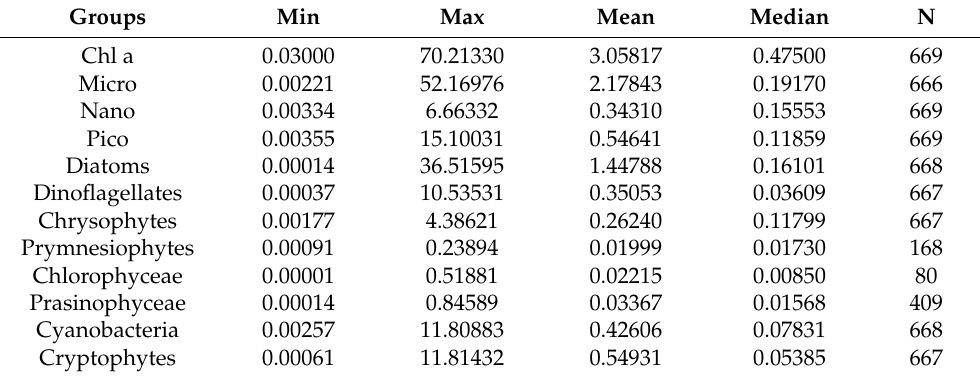
Table 1. Descriptive summary of the phytoplankton groups. Min and Max represent the minimum and maximum values, respectively. N is the number of samples. The unit for all groups is mg · m − 3 .